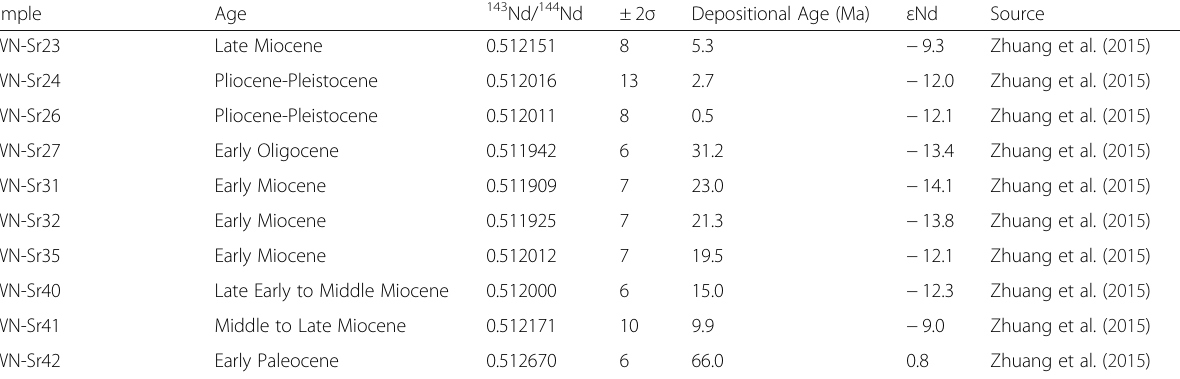
Table 1 Synthesis of published Nd isotope data used in this study, together with a reference to the original sources from which they were derived (Continued)